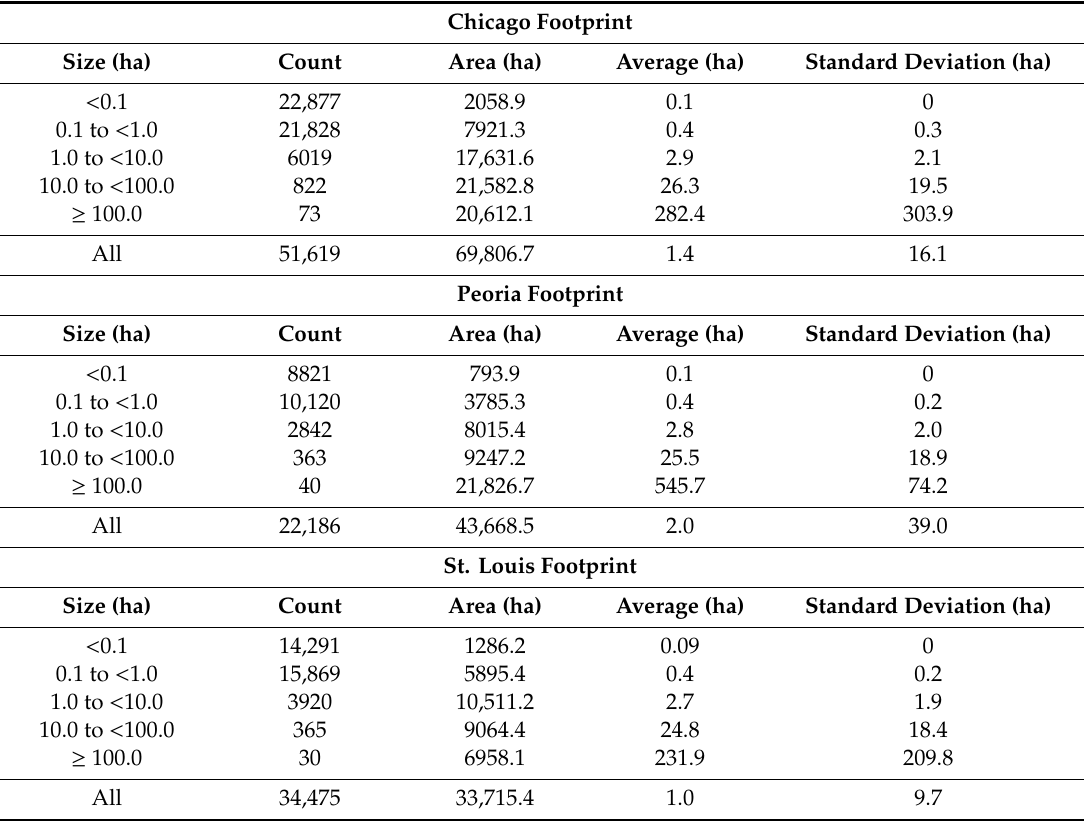
Figure 8. Cumulative LULC change in 90 m areas buffering surface waters between the period 1993–2017 for ( A ) Chicago, ( B ) Peoria, and ( C ) St. Louis footprints. Table 4. LULC change around all study area water bodies was analyzed according to water body size class, ranging from < 0.1 to ≥ 100